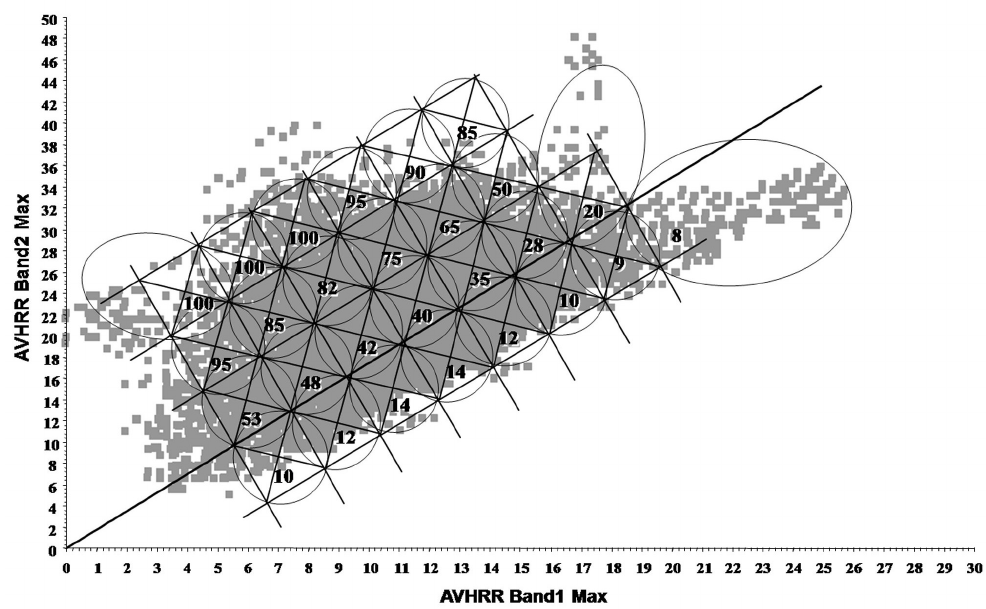
Figure 4. Irrigated area fraction from sub-pixel de-composition technique (IAF-SPDT). The red versus near-infrared reflectivity of every class of a pixel is plotted in a 2-dimensional SPDT plot. Depending on where the pixel falls in SPDT plot and IAF is